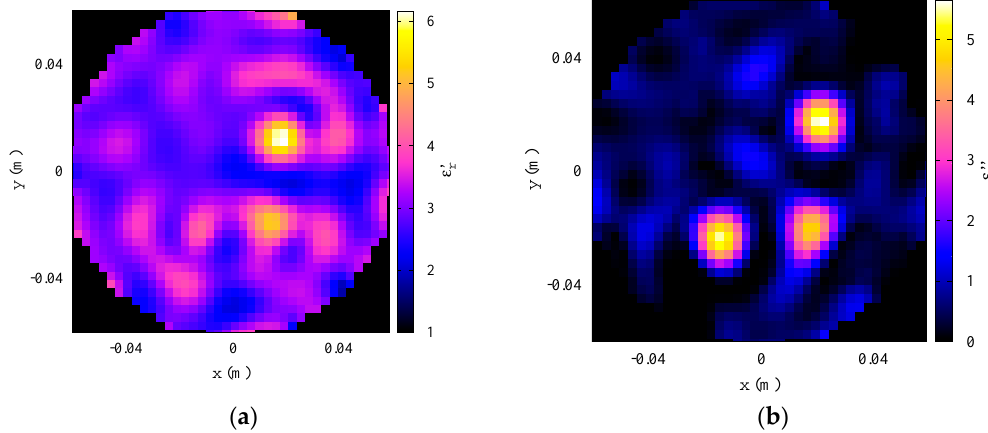
Figure 9. Experimental results. Reconstructed distributions of the ( a ) real part and ( b ) imaginary part of the complex relative dielectric permittivity at 3.8 GHz obtained with a bare quantitative inversion procedure.